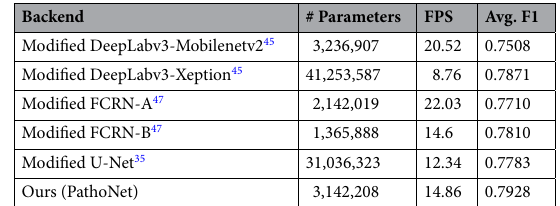
Table 5. Inference speed and model parameters. Run-time in terms of frame per seconds and models’ parameter counts of different backends used in the proposed pipeline.